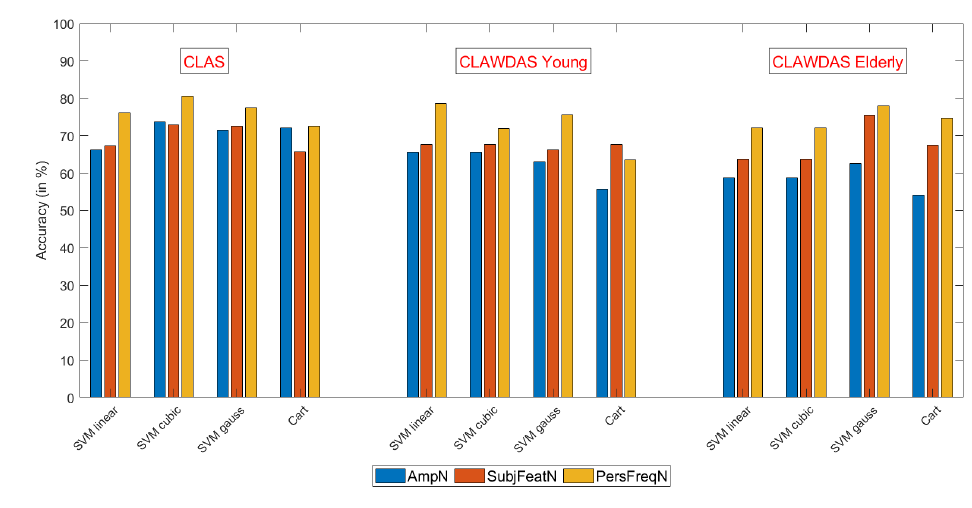
Figure 6. Bar plot comparison of the accuracy obtained using different classifiers and normalization procedures. Three datasets are considered: CLAS, CLAWDAS Young, and CLAWDAS